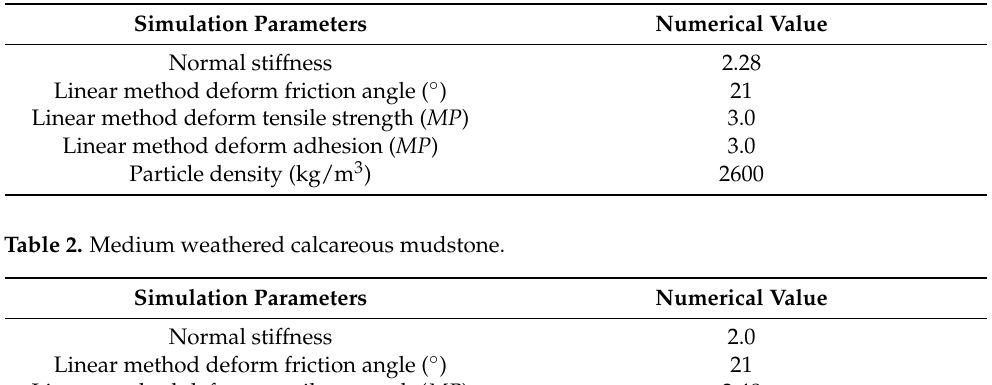
Table 1. Strong weathered calcium argillaceous sandstone.